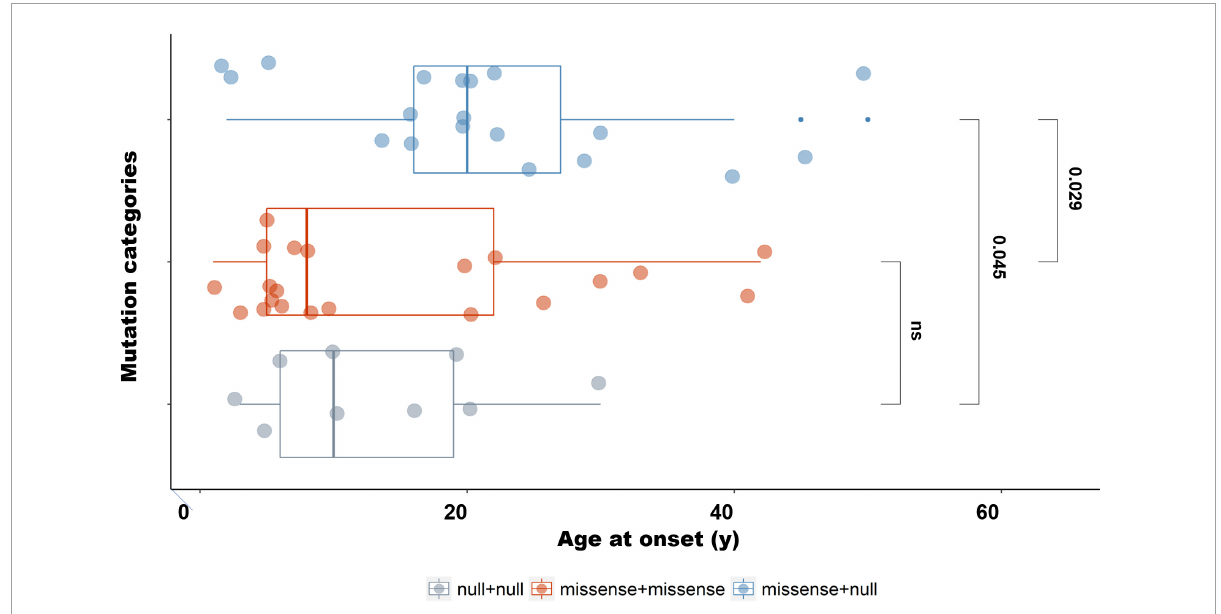
FIGURE4 Age at onset of patients with different mutation types. The age at onset of patients with biallelic missense mutations was significantly younger than that of patients harboring one missense with one null mutation (P adjusted = 0.029). The age at onset of patients with one missense and one null mutation was significantly older than that of patients with biallelic null mutations (P adjusted =